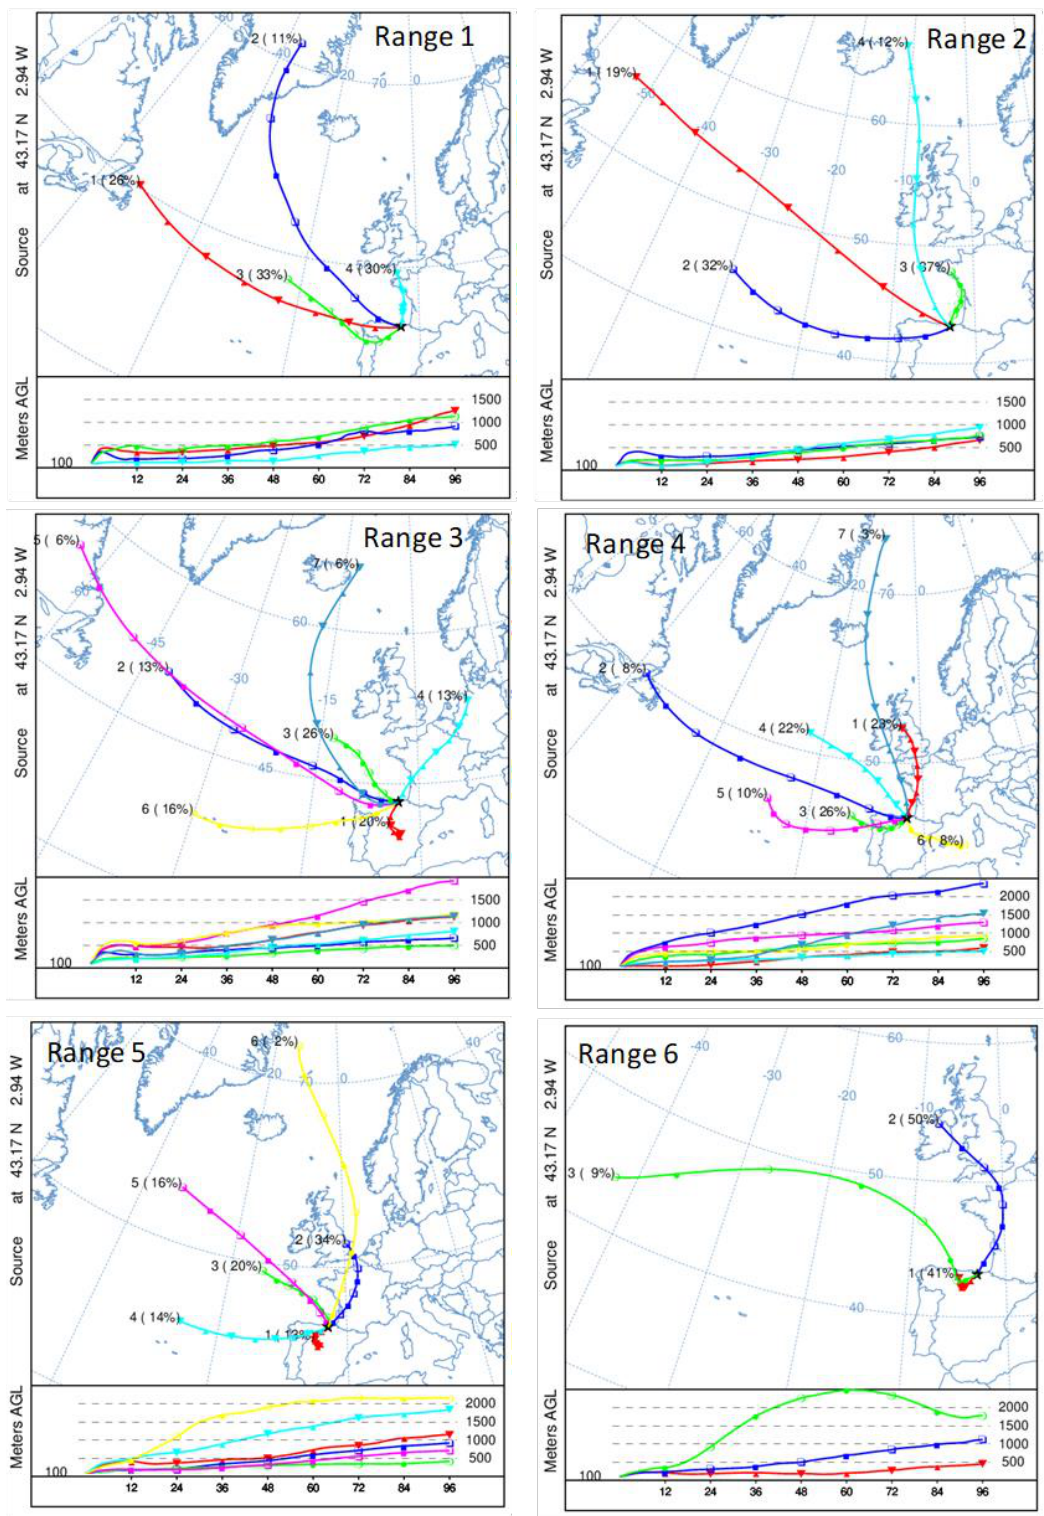
Figure 8. Air mass backward trajectory clusters (computed with HYSPLIT) and their frequencies (in brackets) for each 222 Rn range.